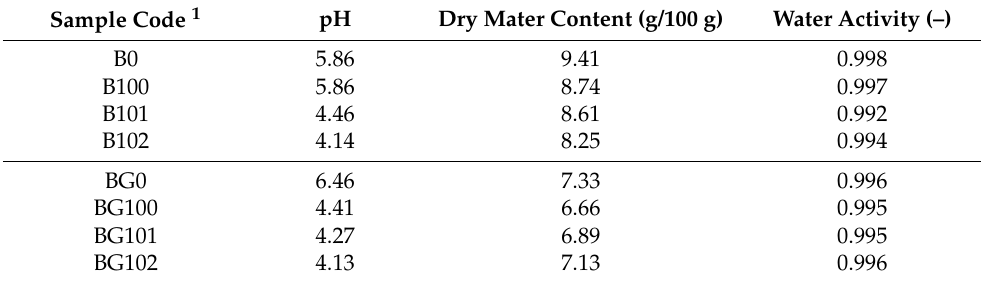
Table 2. Physicochemical characteristics of for B and BG